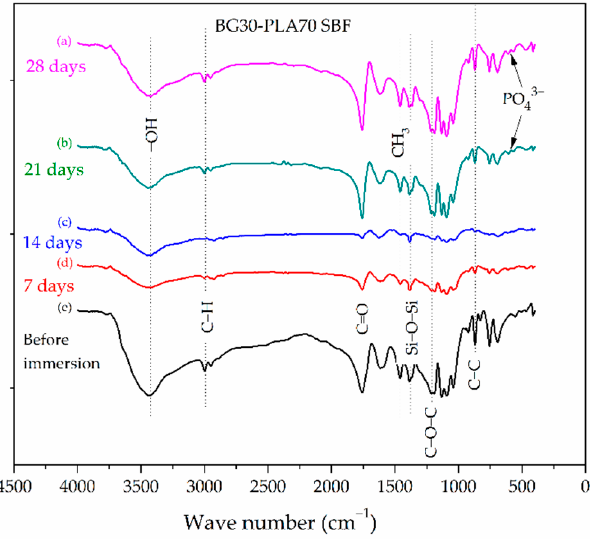
Figure 4. FTIR spectra of the BG30-PLA70 composite after different soaking times in SBF.